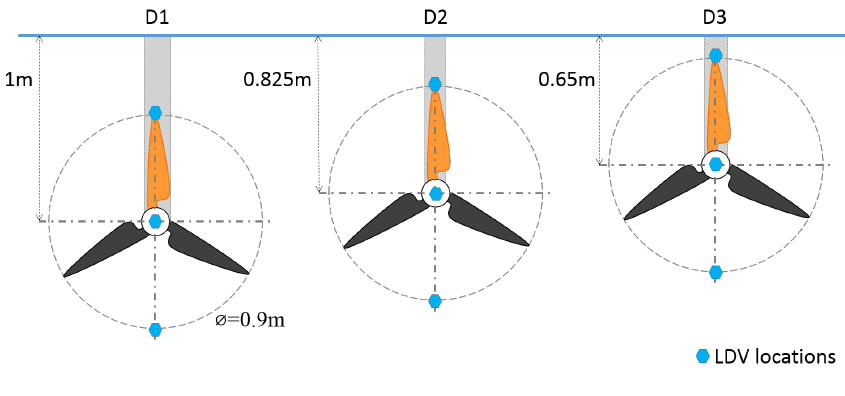
Figure 2. Front view of the rotor indicating the three rotor depths D1, D2 and D3. Blue markers indicate the LDV positions relative to the rotor depth: top, middle,